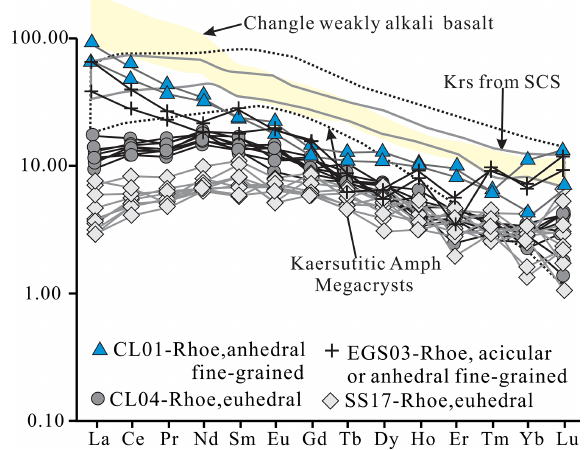
Figure 8. REE contents of Changle rhönite normalized to chondrite (Sun and McDonough, 1989) and compared to kaersutitic amphi- bole (Irving and Frey, 1984) and to weakly alkali basalt (Zeng et al., 2010). “Krs from SCS” is kaersutite from South China Sea, af- ter Yan et al.